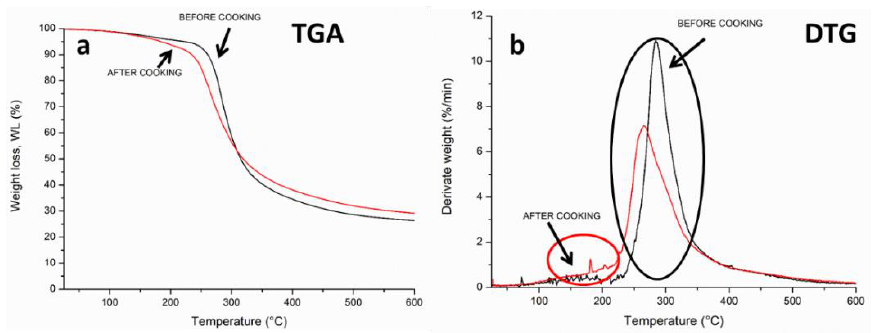
Figure 1. ( a ) TGA thermograms and ( b ) DTG curves of Gnocchi GTW before and after cooking. From the analysis of GTW thermograms, it is possible to observe a lower water content after cooking (black curve). In fact, in Gnocchi dough, both starch and proteins are involved in physical interactions due to the presence of polar residues in both macromo- lecular structures; thus, starch and protein can form a gel when hydrated and heated and the gelling strength is influenced by several factors such as heating rate, holding time and temperature, pH, ionic strength, minerals contents, all factors resulting in a complex phys- icochemical environment [42]. After starch–protein gelation, upon Gnocchi heating and cooling, a chemico-physical aggregation (hydrogen bonds, hydrophobic interaction, and Van der Waals forces) of the polymers occur, likely due to starch retrogradation, a process of recrystallization that takes place during food cooling and storage. In particular, after amylose releasing in boiling water, the branched amylopectin fraction, organizes in a tight and compact structure drastically reducing the available water binding sites. For this rea- son, as expected, the water content in cooked and cooled gnocchi is reduced (Figure 1a). The presence of amino acids influences starch pasting and retrogradation inducing a tight and strong physical network [43]. The main differences are correlated to the loss of food product quality, such as gnocchi staling, loss of viscosity, and of course, syneresis, as evi- denced by Mohamed et al. [44]. Moreover, from the DTG curves (Figure 1b), it is possible to observe two thermal degradation phenomena: the first one is related to the water losing kinetics (red ring) at about 50–100 °C and the second one is due to starch–protein thermal degradation rate at around 300–350 °C [13]. No substantial differences can be found in the decomposition rate of the starch–protein macromolecular network of raw and cooked Gnocchi. As far as GSW samples are concerned, different thermal profiles are reported for bet- ter highlighting their substantial differences before and after cooking. Indeed, both TGA and DTG thermograms are overlapped for raw (Figure 2a) and cooked (Figure 2b) GSW samples. Firstly, in both cases, three thermal degradation phenomena occurred: the first one was ascribed to water releasing in the range of 50–100 °C [45]; the second thermal step was associated with starch–protein decomposition (black ring); the third was correlated to salt decomposition at about 450–500 °C (green curve). In fact, from DTG curves, the maximum degradation rate of raw GSW starch–protein fraction occurred at 250 °C, whereas the same phenomenon was shifted towards a substantially higher temperature (300 °C) for cooked GSW samples. Furthermore, a sharper single peak can be observed for